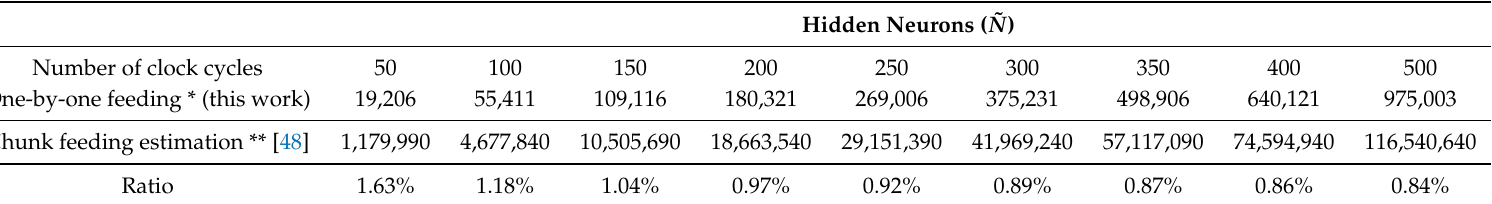
Table 2. Performance comparison between one-by-one and chunk feeding